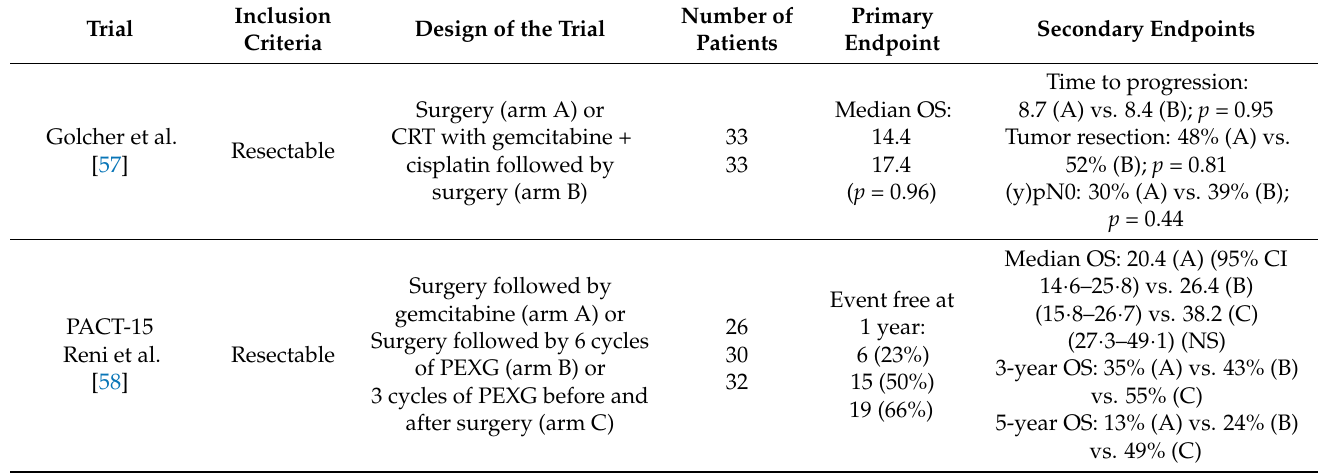
Table 2. Randomized trials of chemoradiotherapy and neoadjuvant